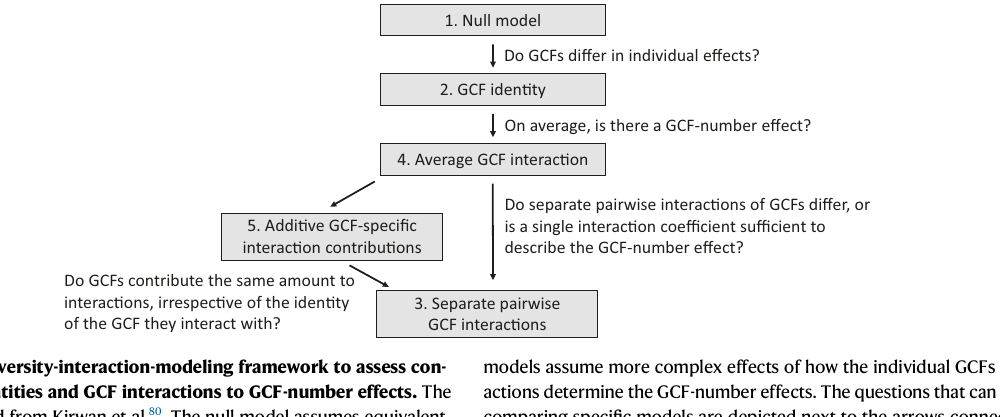
models assume more complex effects of how the individual GCFs and their inter- actionsdetermine theGCF-numbereffects.Thequestions thatcanbe answeredby comparing speci fi c models are depicted next to the arrows connecting the two